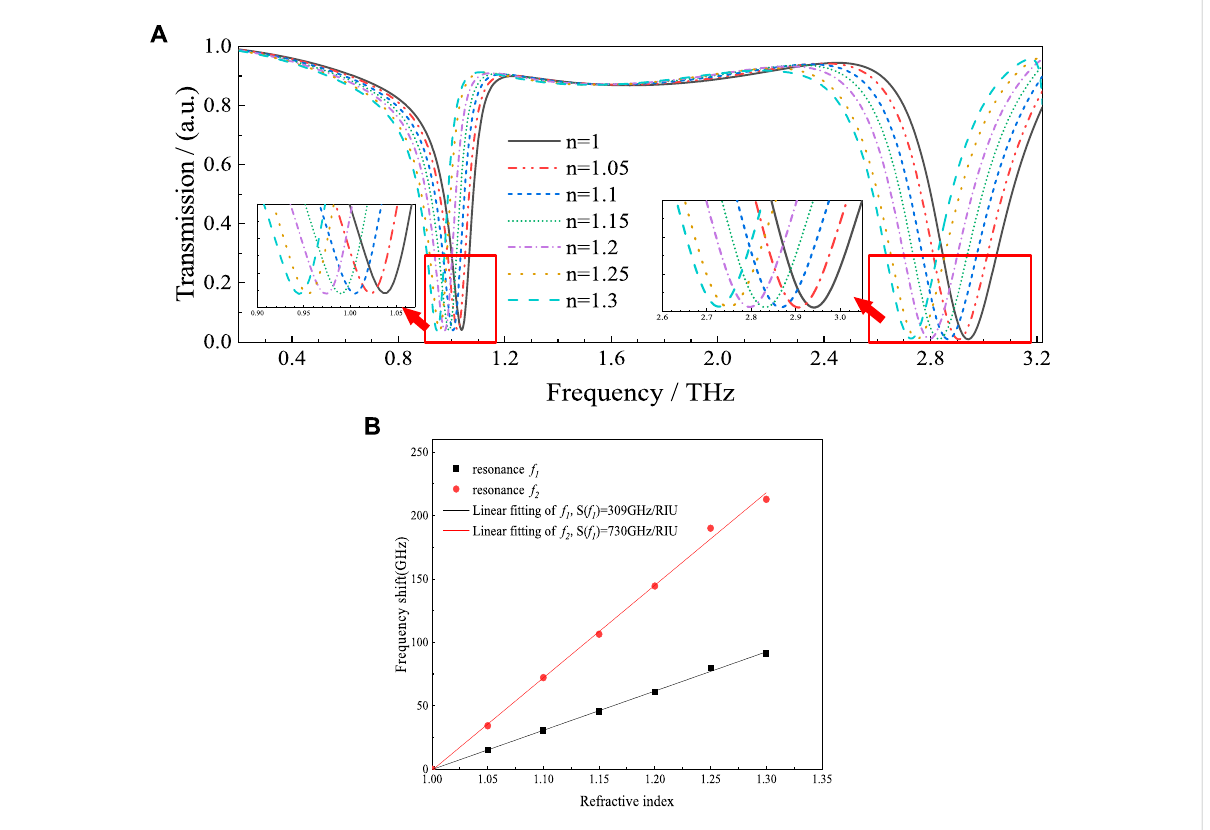
FIGURE 6 (A) The transmission spectra of the proposed sensor with the changes of the RI of analytes; (B) Resonant frequency shift of the sensor as a function of refractive index and the linear fi tting results.